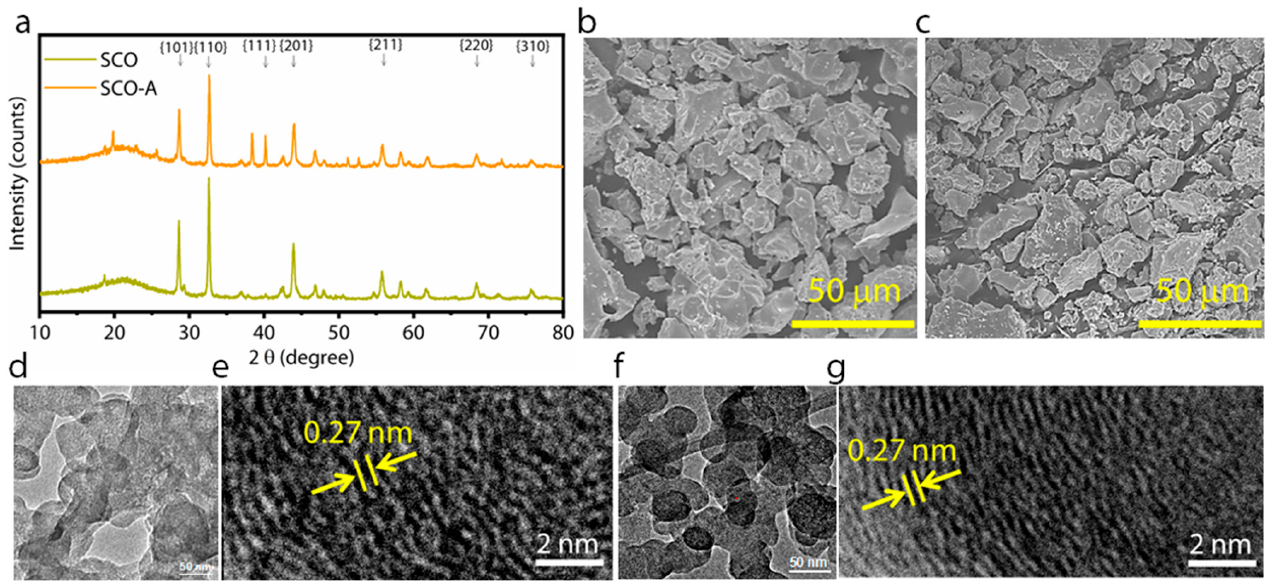
Figure 1. Crystal structure and physical characterizations. ( a ) X-ray diffraction pattern of perovskite SCO and SCO-A. SEM images of ( b ) SCO; ( c ) SCO-A. TEM images of ( d – e ) SCO; ( f – g ) SCO-A.